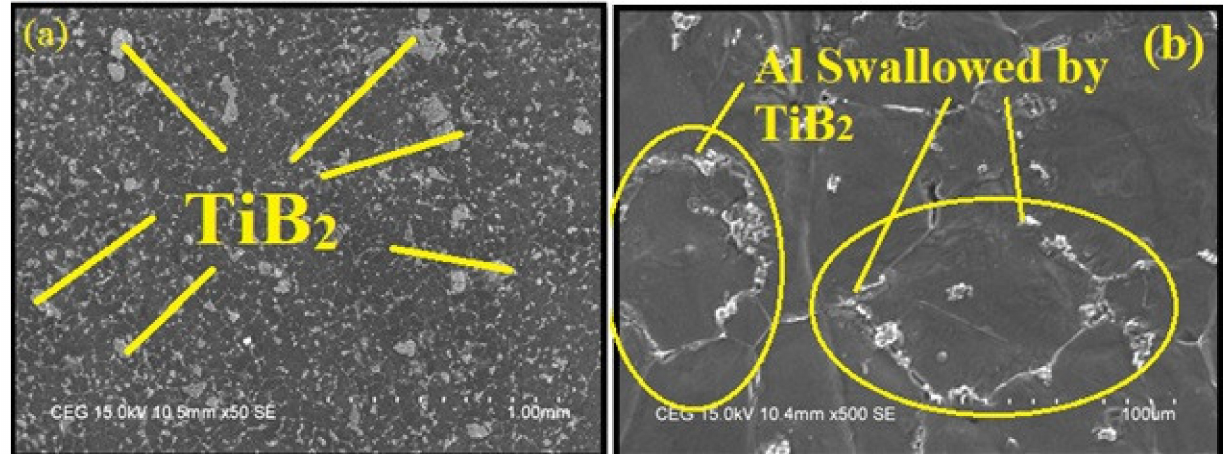
Figure 2. Field-emission scanning electron microscopic (FESEM) images of AA7075/12 wt.% TiB2 aluminum matrix composites (AMC) at ( a ) 50 SE (low magnification) and ( b ) 100 SE (high magnification).